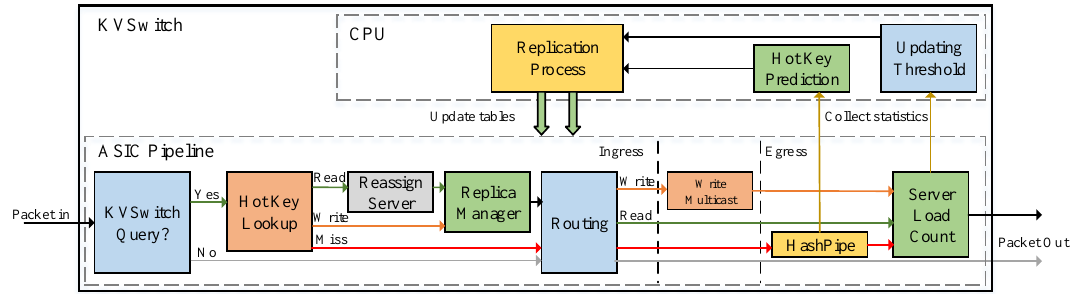
Figure 3. Logical view of KVSwitch. Algorithm 1: